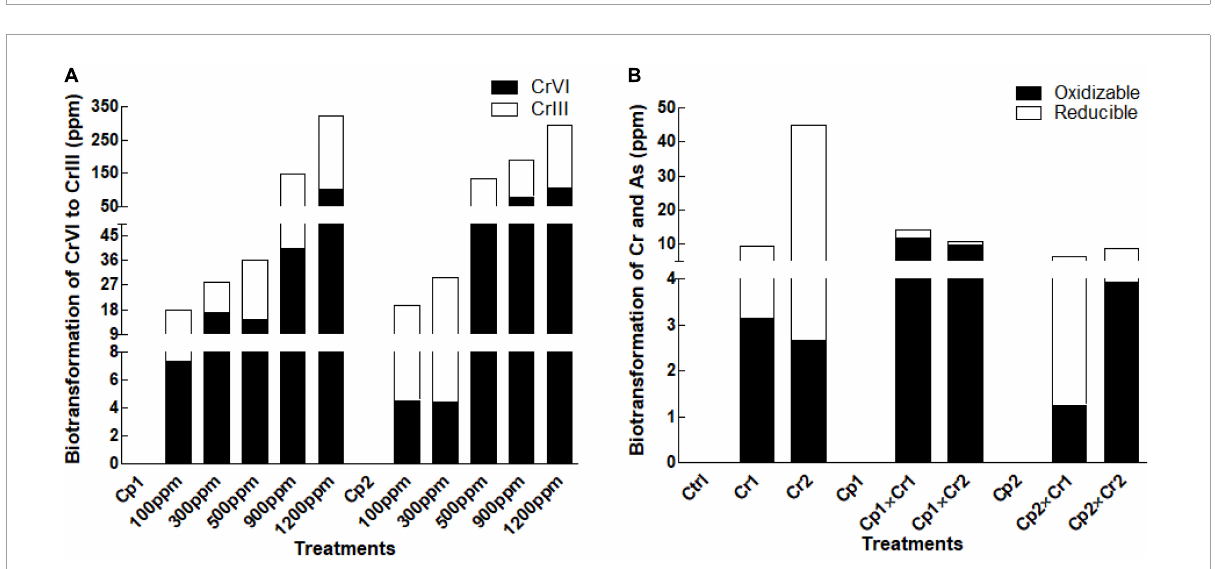
FIGURE6 Biotransformation of (A) Chromate in fungal culture filtrate (B) Chromate in soybean plants inoculated with Stemphylium lycopersici and Stemphylium solani using the BCR sequential extraction procedure. Each bar represents mean of triplicated data ( n = 3).